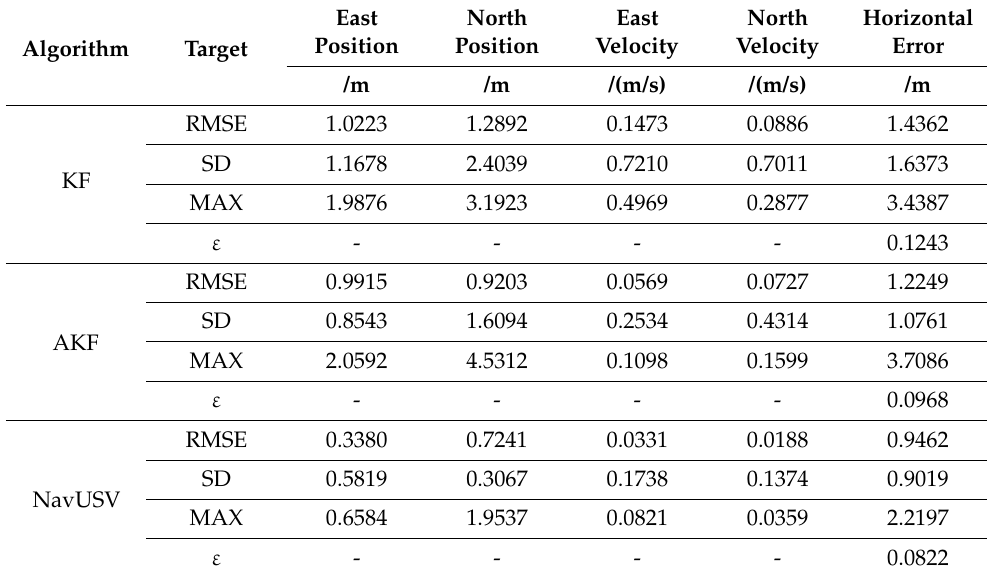
Table 3. Statistical analysis of information fusion with KF, AKF, and NavUSV.